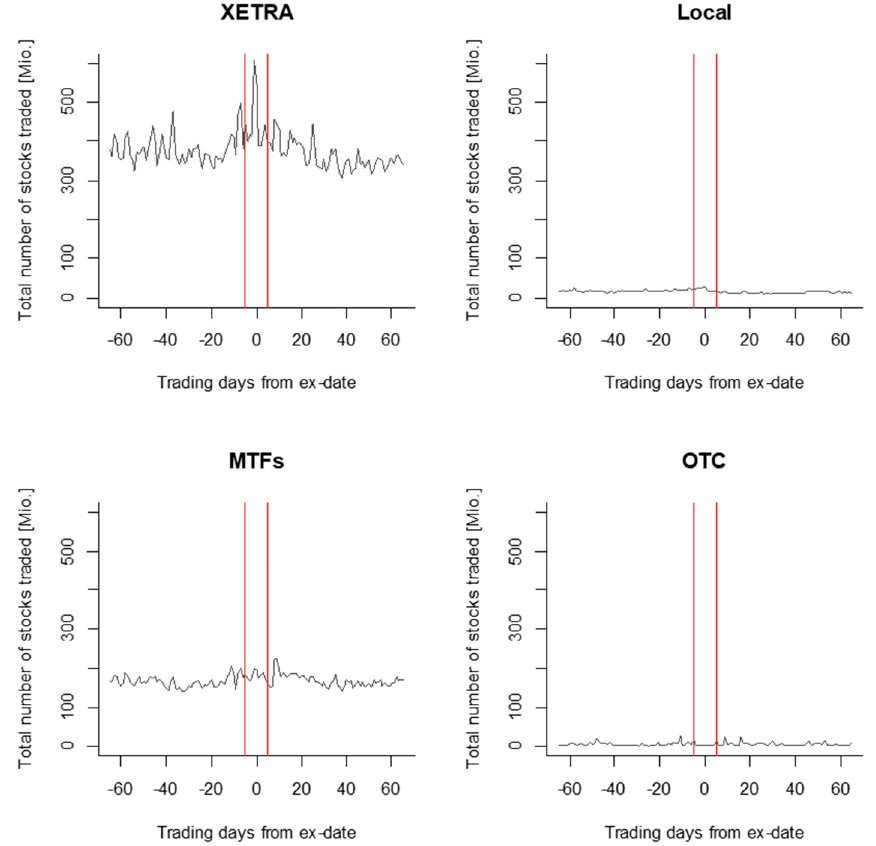
year. The data sample includes 456 ex-dates with tax-free dividend payments. Data source: Refinitiv